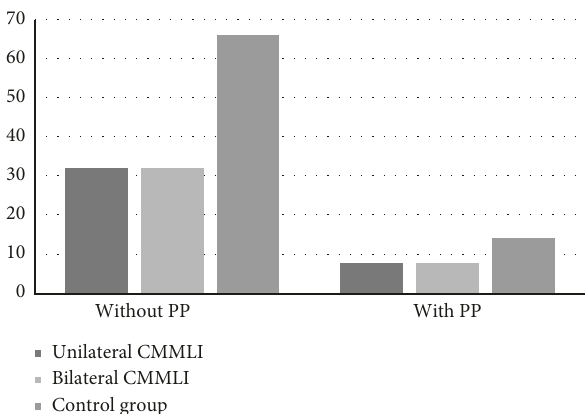
Figure 5: The prevalence of PP in case and control groups ( P � 0 . 12 for both unilateral and bilateral compared to the control group).